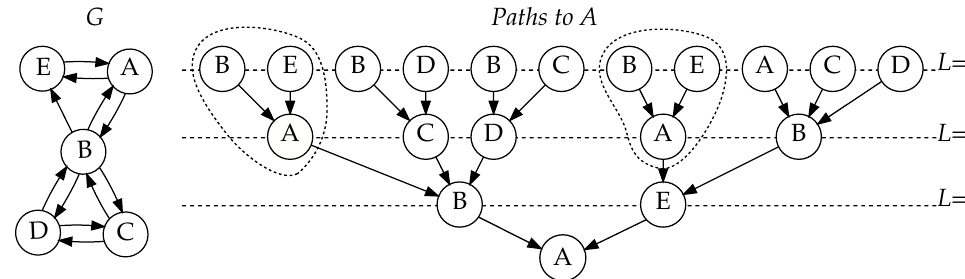
Figure 1. Network G , and a tree of all paths ending at node A in network G , with length at most 3, illustrating how paths are combined at their last common node.